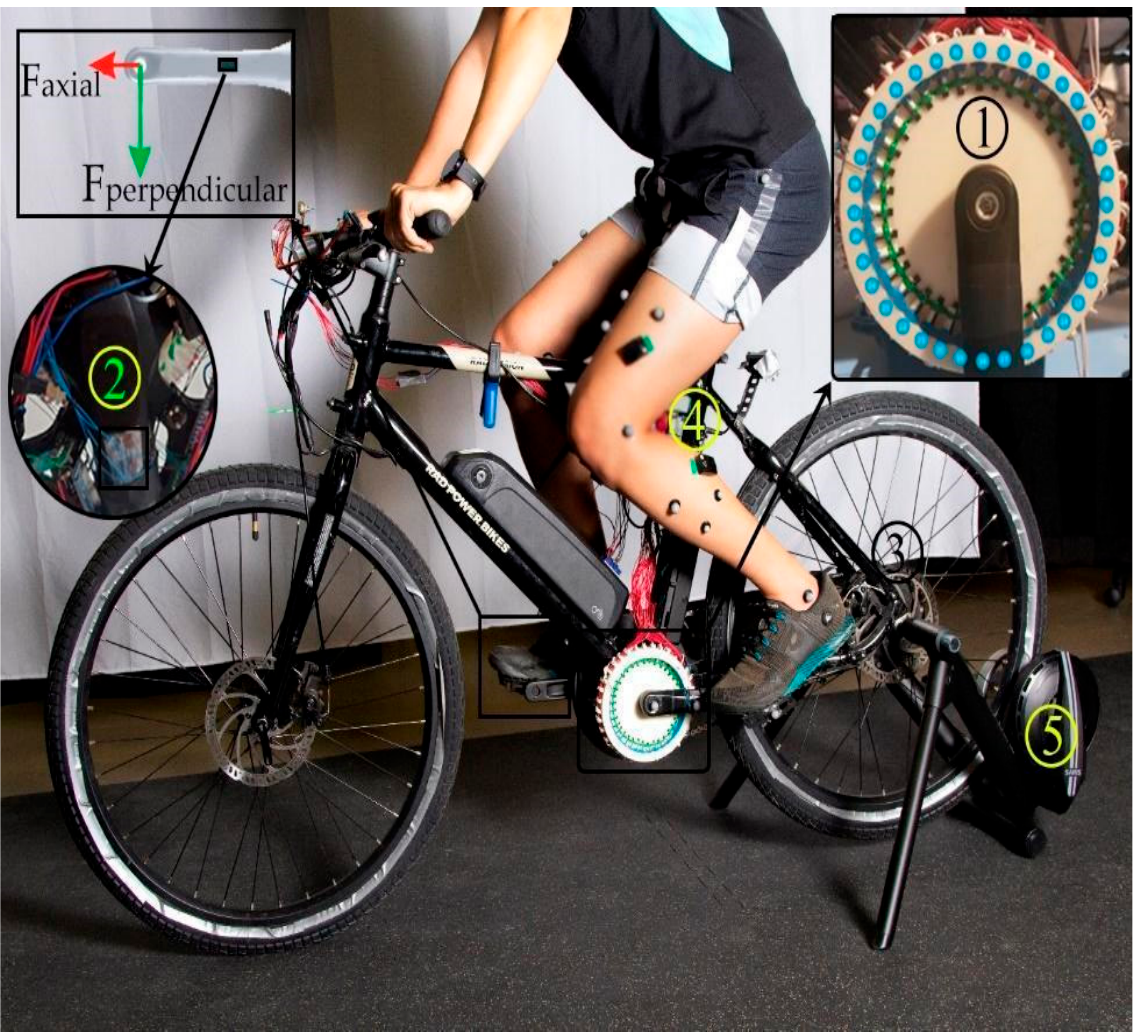
Figure 1. The APAD consisted of a crank position sensing system (1) and force sensor (2), BLDC rear hub motor (3), and a controller (4). The APAD was mounted on a trainer (5) for testing in the motion capture lab. The crank tracking unit consisted of 36 hall sensors on the 3D-printed fixture. The strain gauges-based force sensor measured the crank's perpendicular force. The ID number of each hall sensor to the controller is pictured along the circumference of the unit.